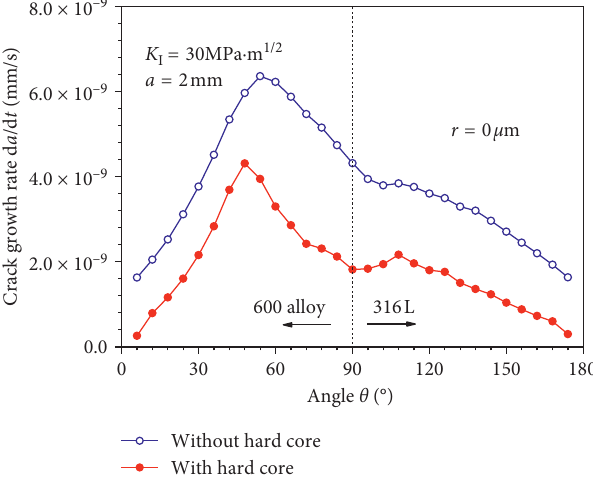
Figure 11: Effect of distance of the crack from the fusion line on the creep rate.